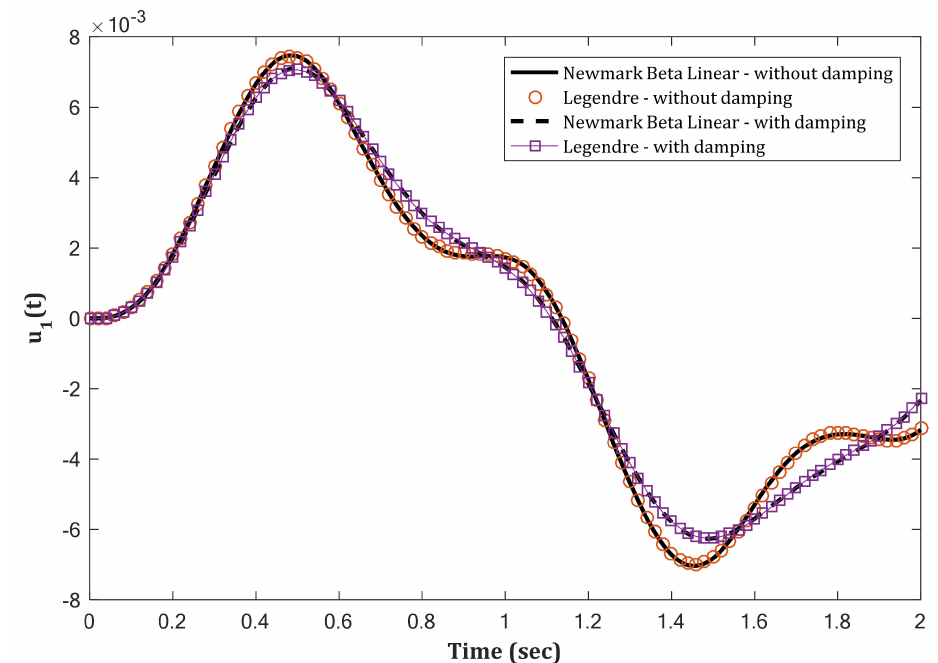
Figure 5. Forced vibration analysis of a 2DOF system. Comparison of u 1 ( t ) as a function of time, as obtained from the LGM method or the linear Newmark- β method.